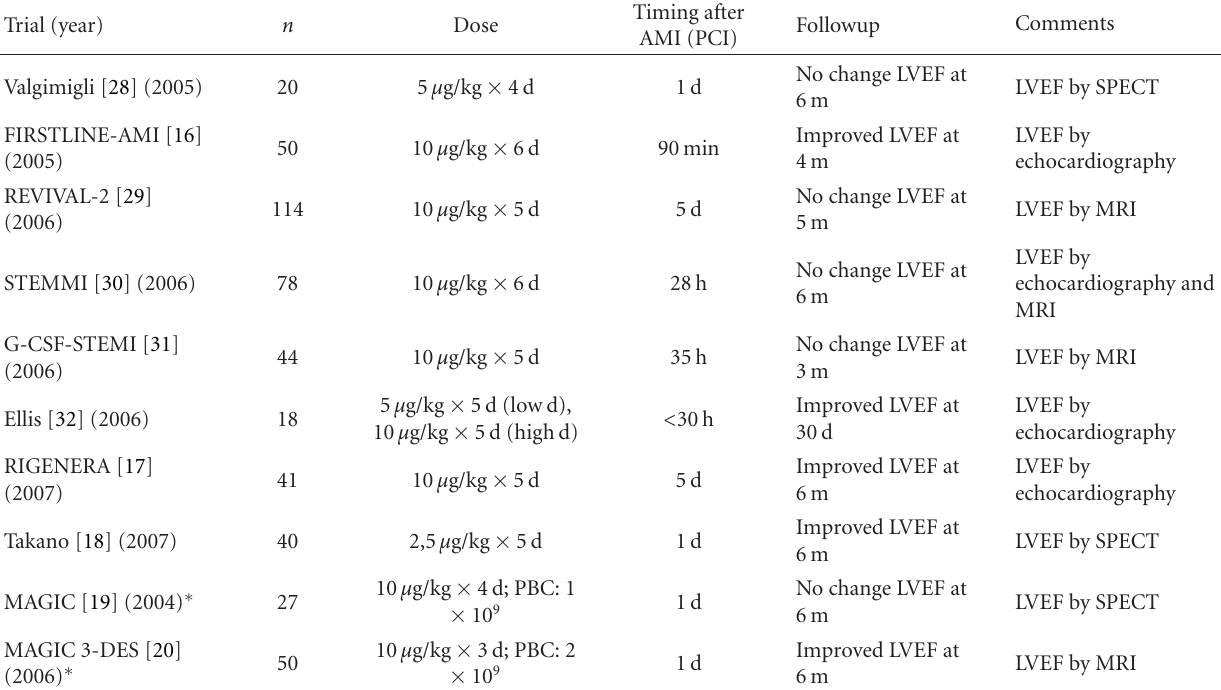
Table 2: Randomized clinical trials with granulocyte colony-stimulating factor in patients with acute myocardial infarction (subcutaneous).